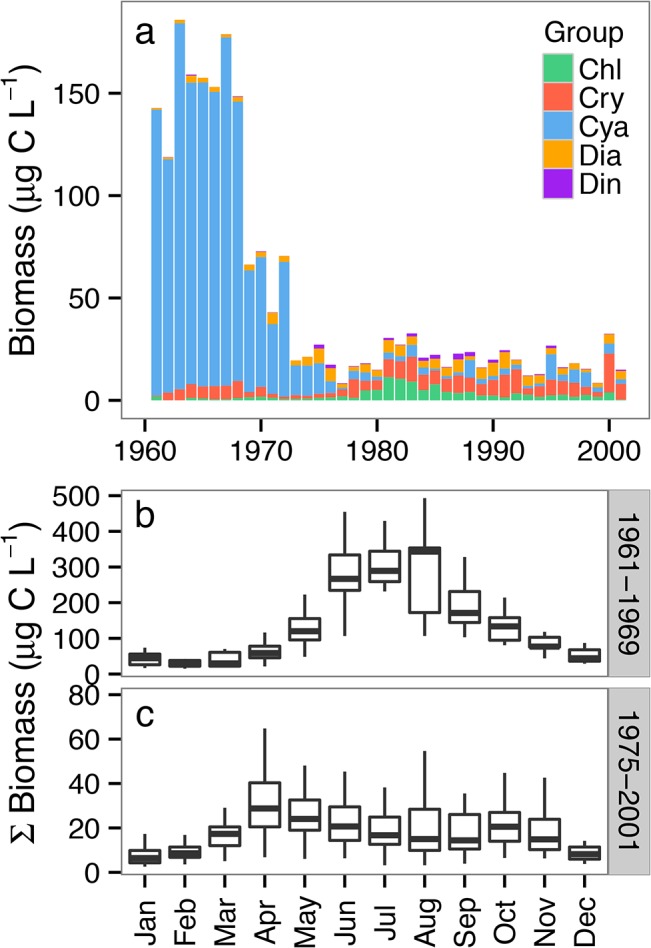
Lake Washington annual and monthly phytoplankton biomass from 1961–2001.(a) Stacked barplots of annual average phytoplankton biomass, color-coded by taxonomic group, from 1961–2001. Boxplot of average total phytoplankton biomass during the (a) eutrophic years (1961–1969) prior to sewage treatment, and (b) the oligotrophic years (1975–2001) after the transition (1970–1974) to sewage treatment in Lake Washington. Abbreviations follow Fig 1.